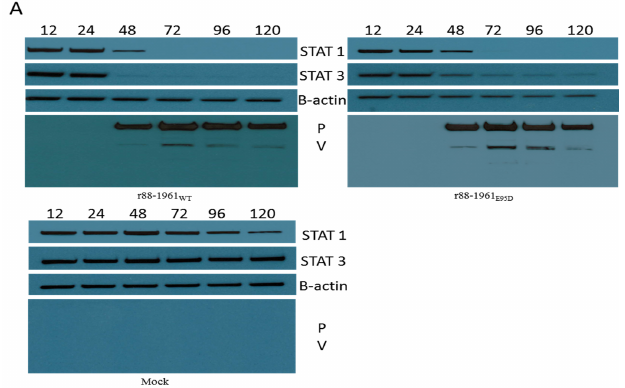
Figure 2. The severity of hydrocephalus and in vivo growth kinetics in rats inoculated with r88-1961 WT and r88-1961 E95D . ( A ) Newborn rats were inoculated i.c. with r88-1961 WT (31 animals) and r88-1961 E95D (26 animals) and euthanized one month later. The brains were then removed, and hydrocephalus scores calculated. The vertical lines in each box plot represent the maximum and minimum hydrocephalus score values, respectively, for a given virus, while the horizontal lines within each box represent the median scores. The mean scores for each virus are indicated at the top of each plot. ( B ) Newborn rats (5 animals per time point) were inoculated intracerebrally with r88-1961 WT and r88-1961 E95D and euthanized on days 1–4, 6 and 8 post inoculation. The brains were processed, and viral titer determined. Error bars represent standard error of the mean, and the dashed horizontal line indicates the limit of detection of the assay. ( C ) Maintenance of the wild type V nucleotide (G) in r88-1961 WT and the presence of the engineered substitution (T) in r88-1961 E95D was confirmed in brain lysates prepared from rats inoculated intracerebrally with r88-1961 WT and r88-1961 E95D and euthanized on day 3 post inoculation. The sequence was confirmed independently in three rat brains per virus variant.